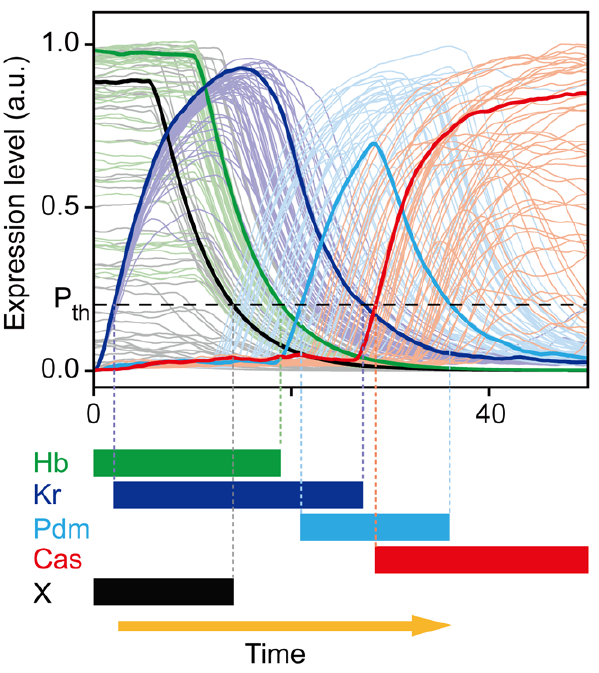
Figure 4. Temporal dynamics of the Drosophila network in the continuous model. The dynamics of expression levels of proteins { P i ( t )} with different parameter values (upper) and discretized represen- tation of a typical temporal dynamics (lower). In addition to the known genes, the presumptive factor x is also incorporated. The expression level of X changes from a high level to a low level as in the previous model. Each gene is considered to be in the ON state when the expression level is larger than a threshold P th . The parameter values of (cid:6) (cid:7) and { S ~ JJ ij i } are randomly selected from the following ranges: (Fig. 7B–E), the ranges are narrower for some parameters (as clearly seen in S pdm and S cas ), and the numbers of successful parameter sets are less than those obtained for the Drosophila network.